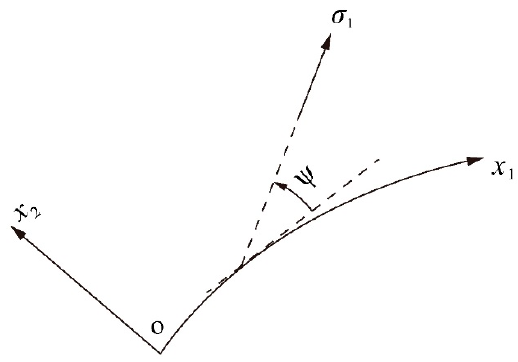
Figure 2. Orientation of the major principal stress.